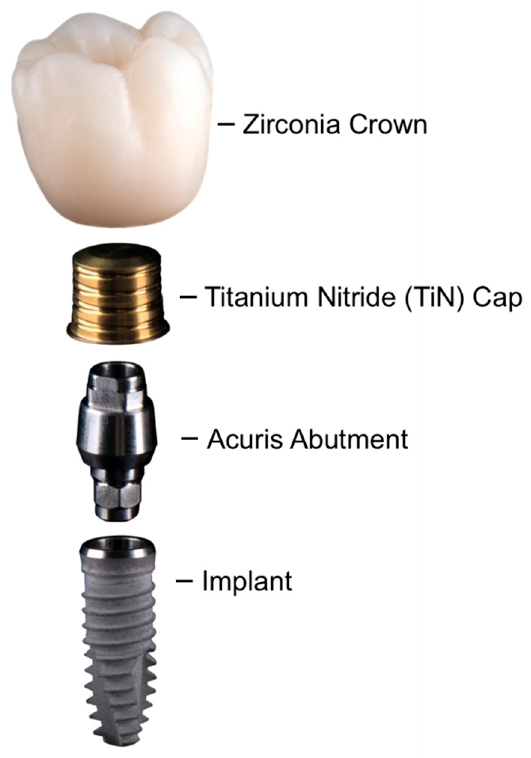
Figure 4. Schematic diagram of the Acuris conometric concept with the Xive implant